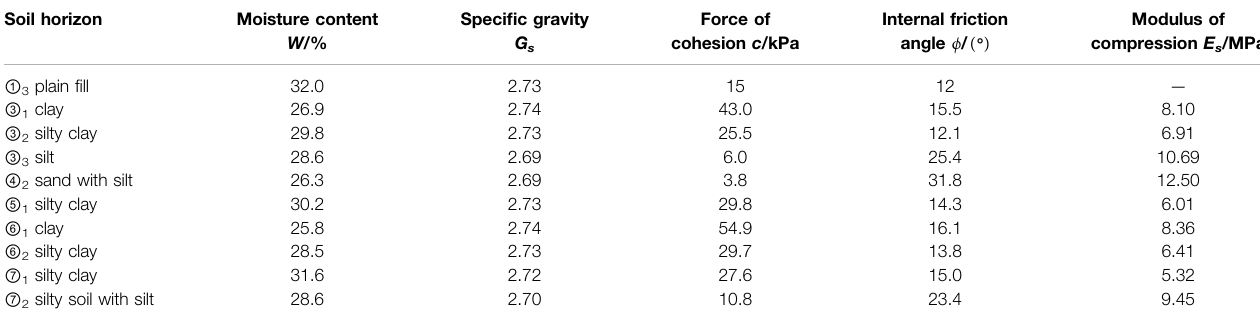
TABLE 1 | Physical and mechanical parameters of the soil layer. Soil